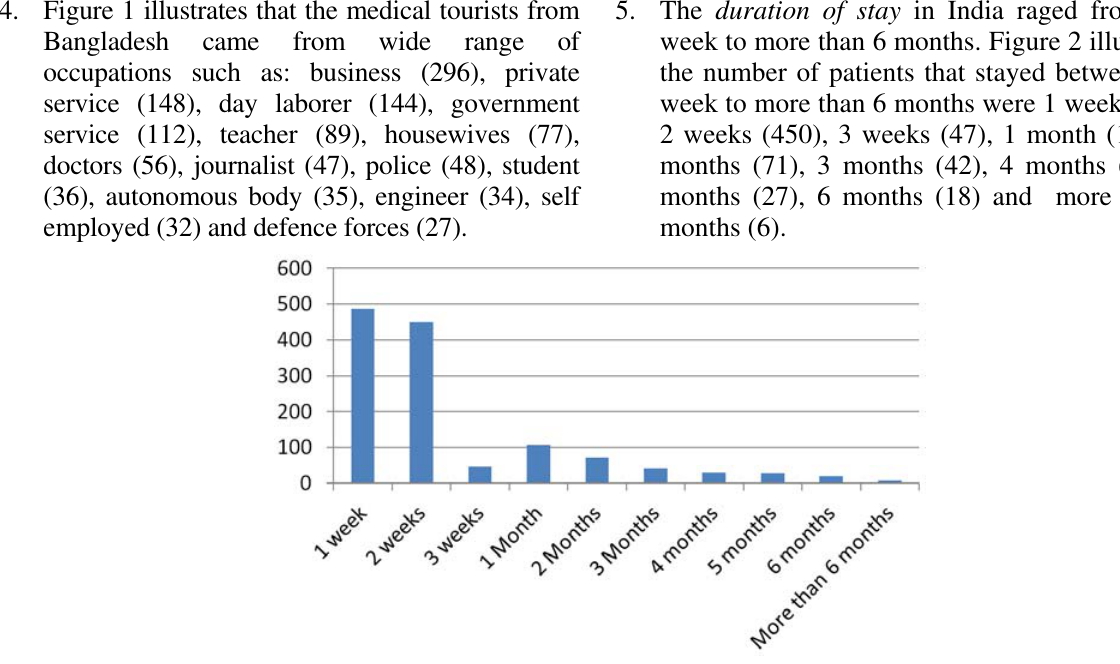
Fig. 2. Bangladeshi medical tourists staying period Source: developed for this